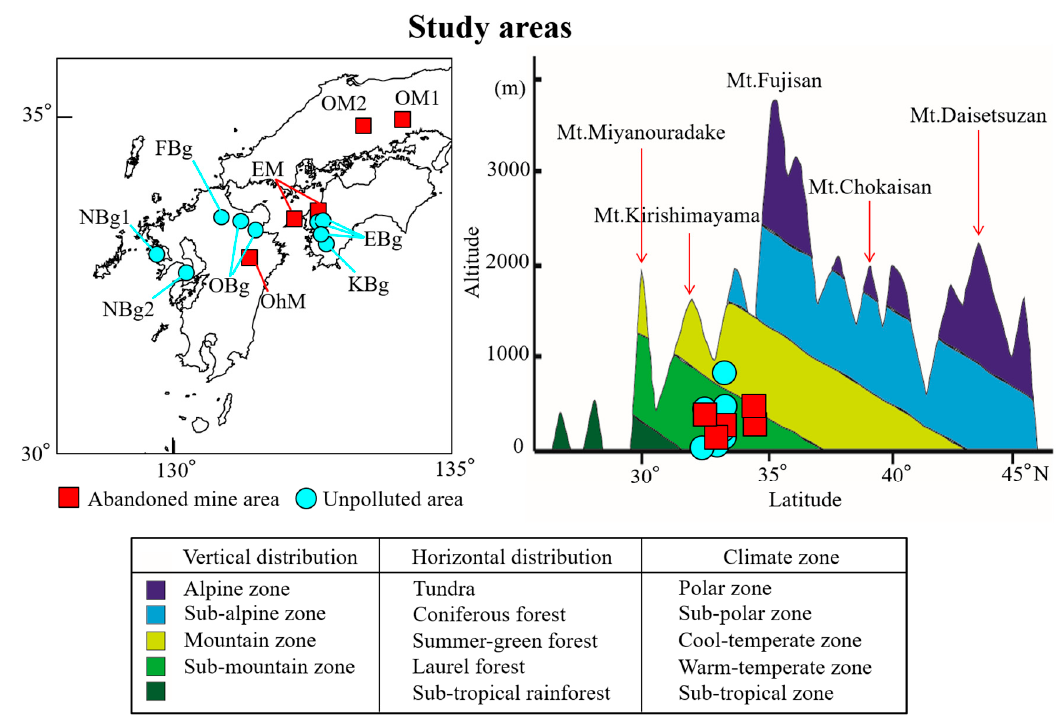
Figure 1. Locations of this study areas and their climate zone.